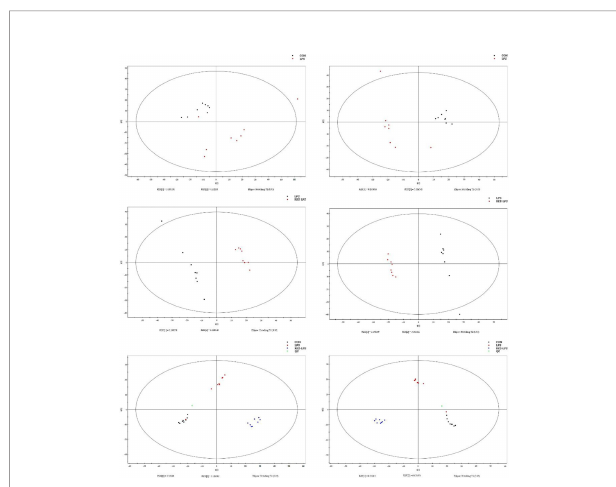
FIGURE 3 | Score plots of principal component analysis and PLS-DA models with their corresponding R2X and T2 values. Score plots between two and three groups.